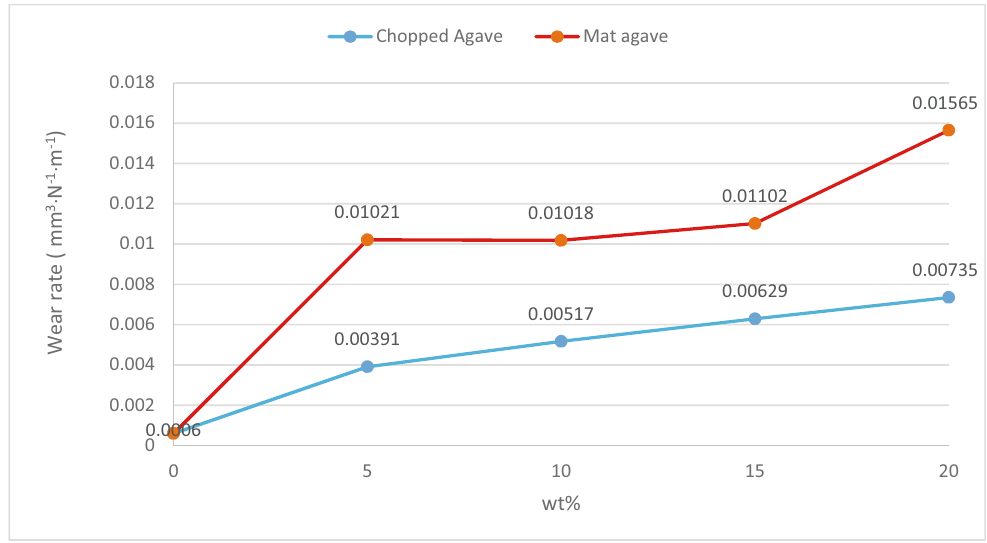
Figure 6: The WR of agave fi ber – polyester composite at diverse wt% and